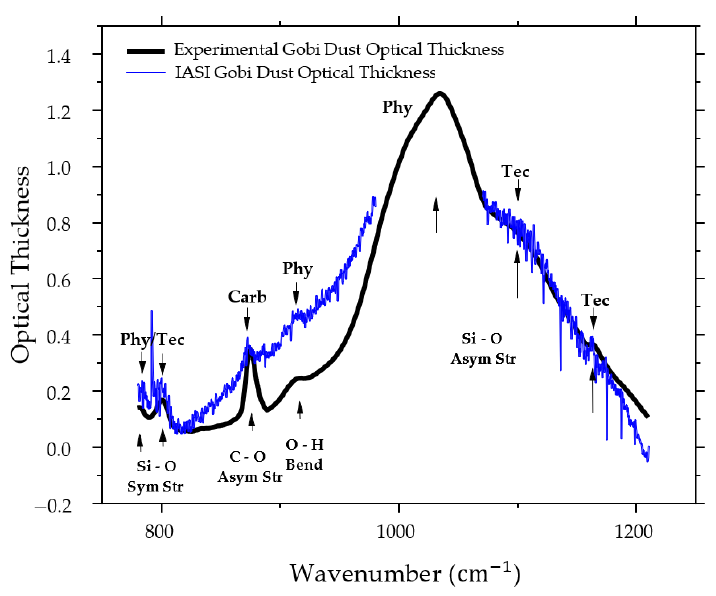
Figure 12. The laboratory Gobi dust spectrum with the molecular assignment for each fingerprint is in black. Sym Str: symmetrical stretching; Asym Str: asymmetrical stretching; Bend: bending. The IASI spectral residue detection of the dust plume on 4 May 2017, at daytime after LSE correction, with mineralogical family assignment, is in blue. Tec: tectosilicates; Phy: phyllosilicates; Carb: car-